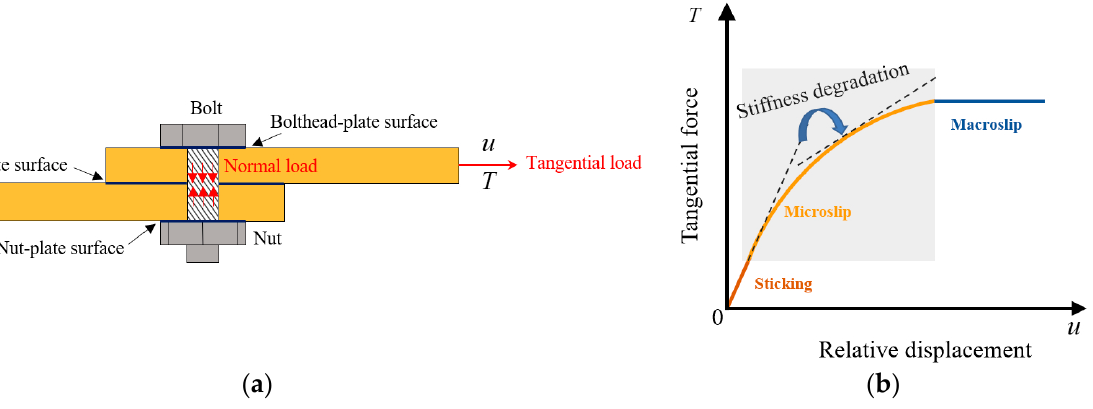
Figure 1. The stiffness degradation of the bolted joint under mixed-mode loading: ( a ) the mixed-mode loading, ( b ) the backbone curve.